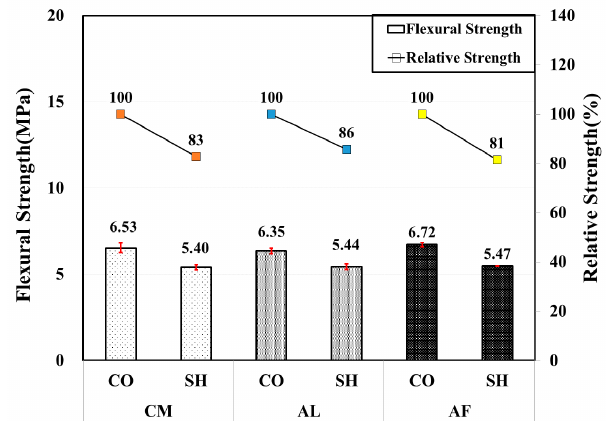
Figure 12. Flexural strength by accelerators for 24-month-old specimens.